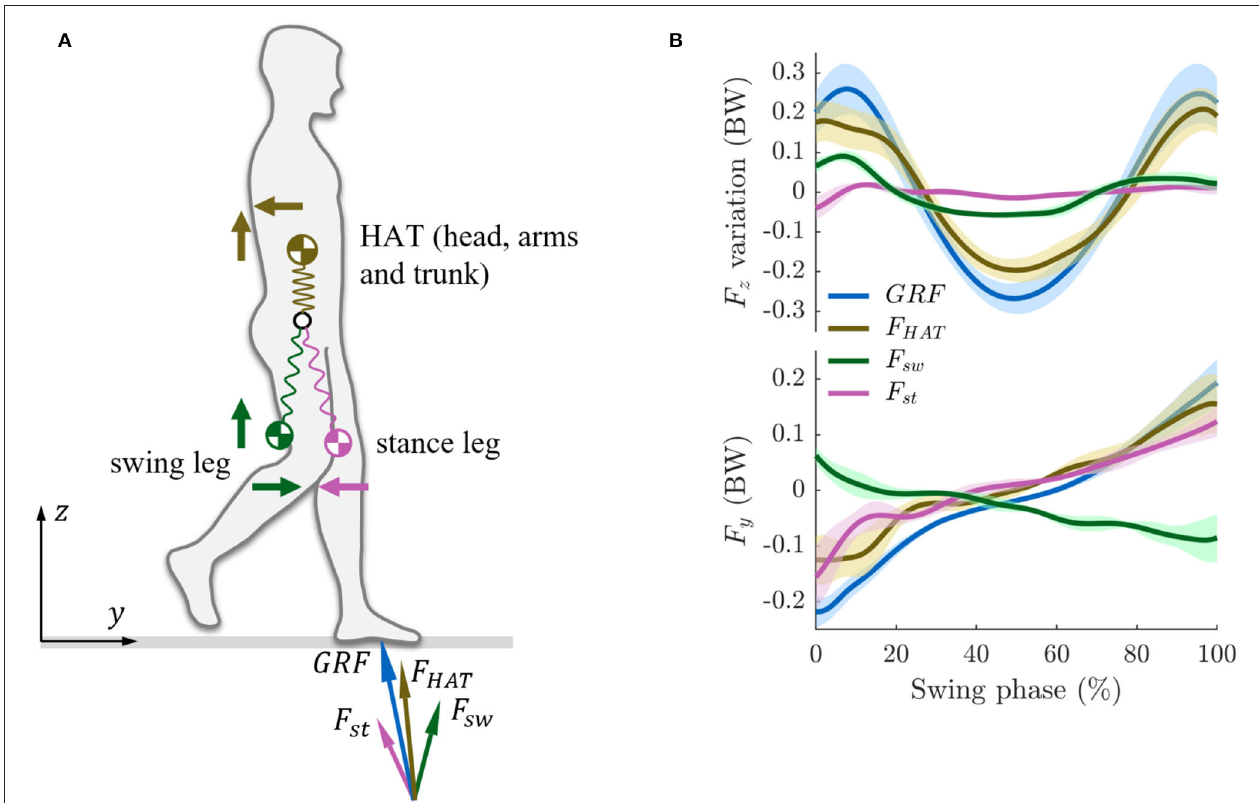
FIGURE 1 | (A) Mechanical coupling between the upper body (head, arms, and trunk, HAT) and the lower body (swing leg and stance leg) during walking. The Ground Reaction Force (GRF) is decomposed into the vectors F HAT , F sw , and F st denoting the inertial forces (the mass multiplied by the acceleration) of the HAT, swing leg, and stance leg. (B) F z and F y denote the inertial forces in vertical and horizontal (fore-aft) directions. The forces are normalized to body weight (BW). We do not show the full gait cycle, but only the swing phase as we describe the interaction between the stance leg, swing leg, and the upper body. During walking, following the swing phase, there is a double stance phase during which the upper body continues to move forward due to inertia and then triggers the next swing